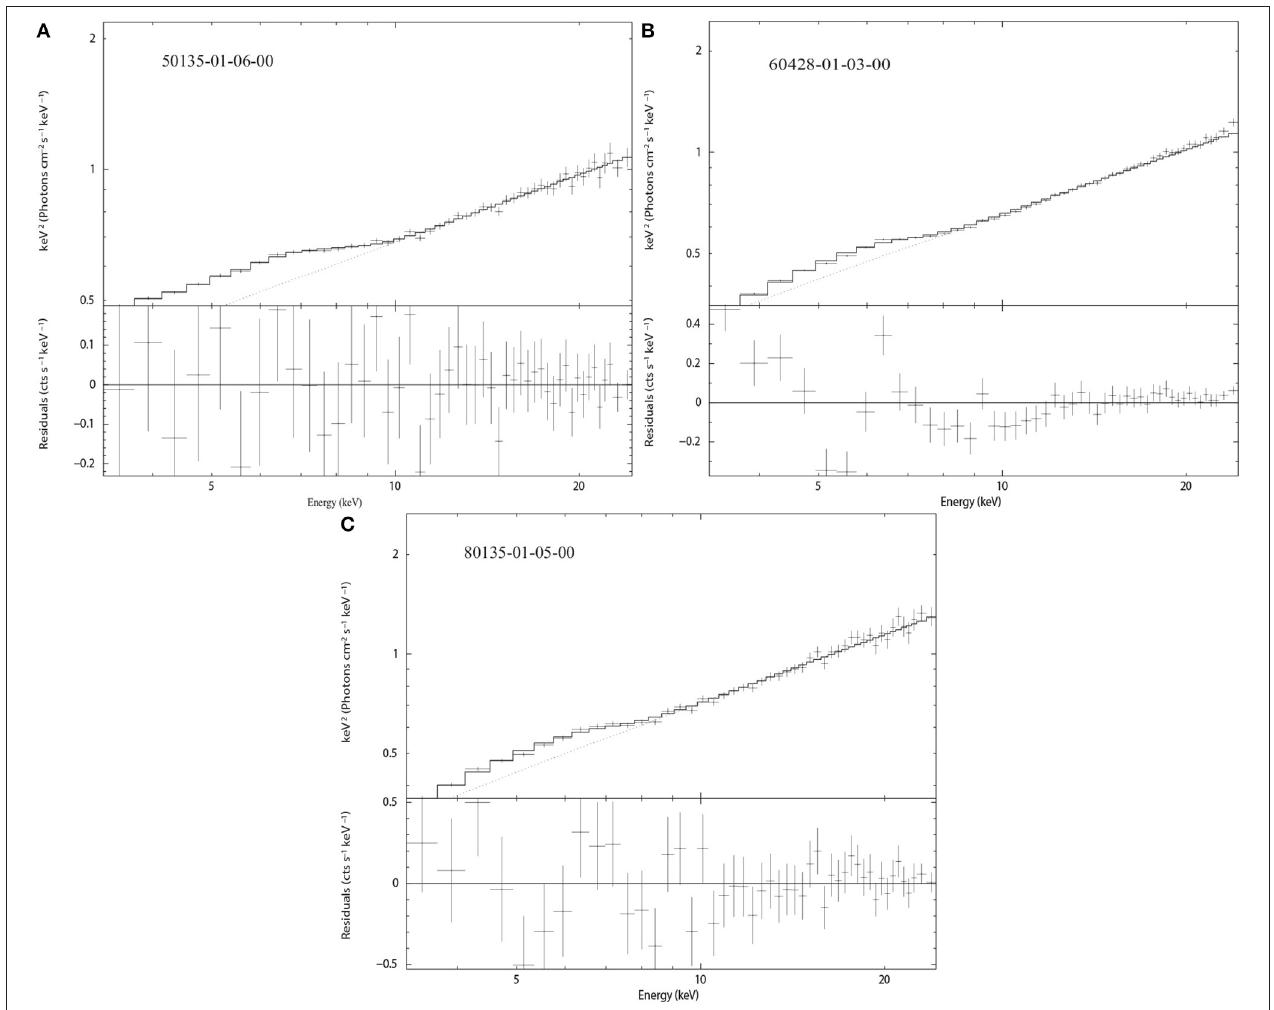
FIGURE 4 | The X-ray spectra and residuals of A , B , and C